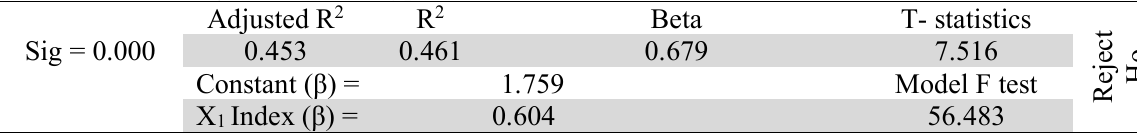
The results of testing the first sub-hypothesis